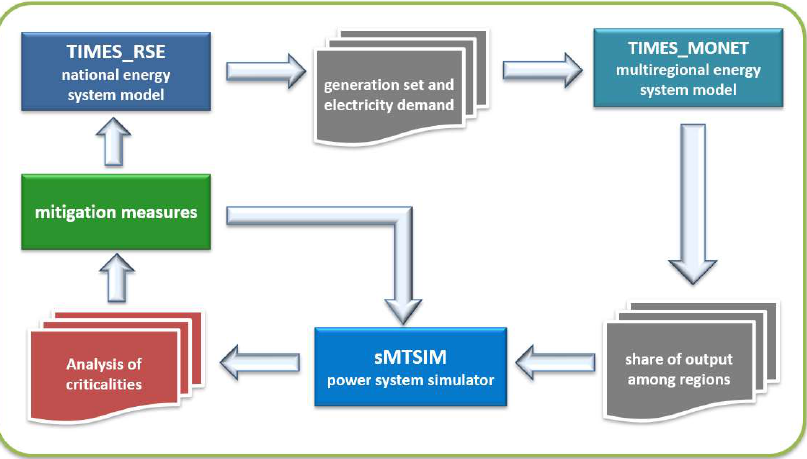
Figure 1. Methodology for analyzing the impact of energy scenarios on power system.